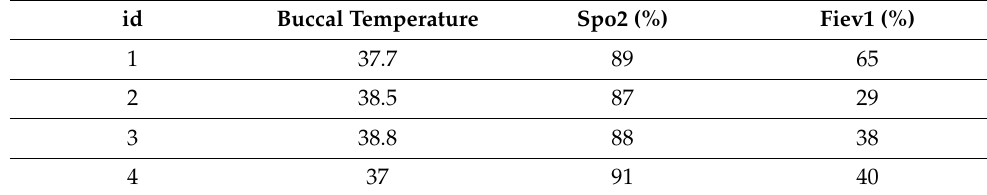
Table 7. Example of vital sign parameters